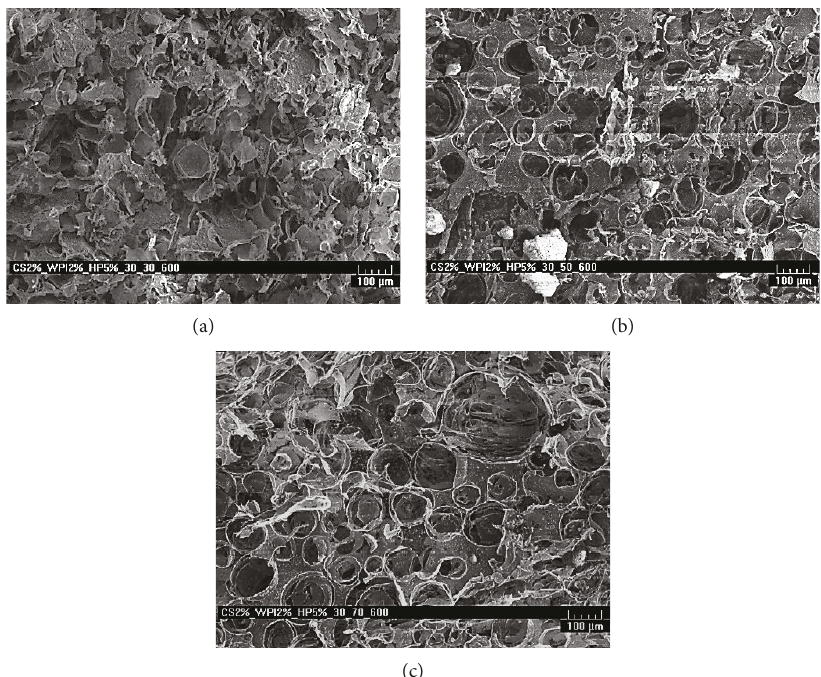
Figure 5: SEM micrographs of the CS/WPI/HAp sca ff old obtained using the continuous process varying gas fl ow rate incorporation. (a) 30mL min -1 , (b) 50 mLmin -1 , and (c) 70 mLmin -1